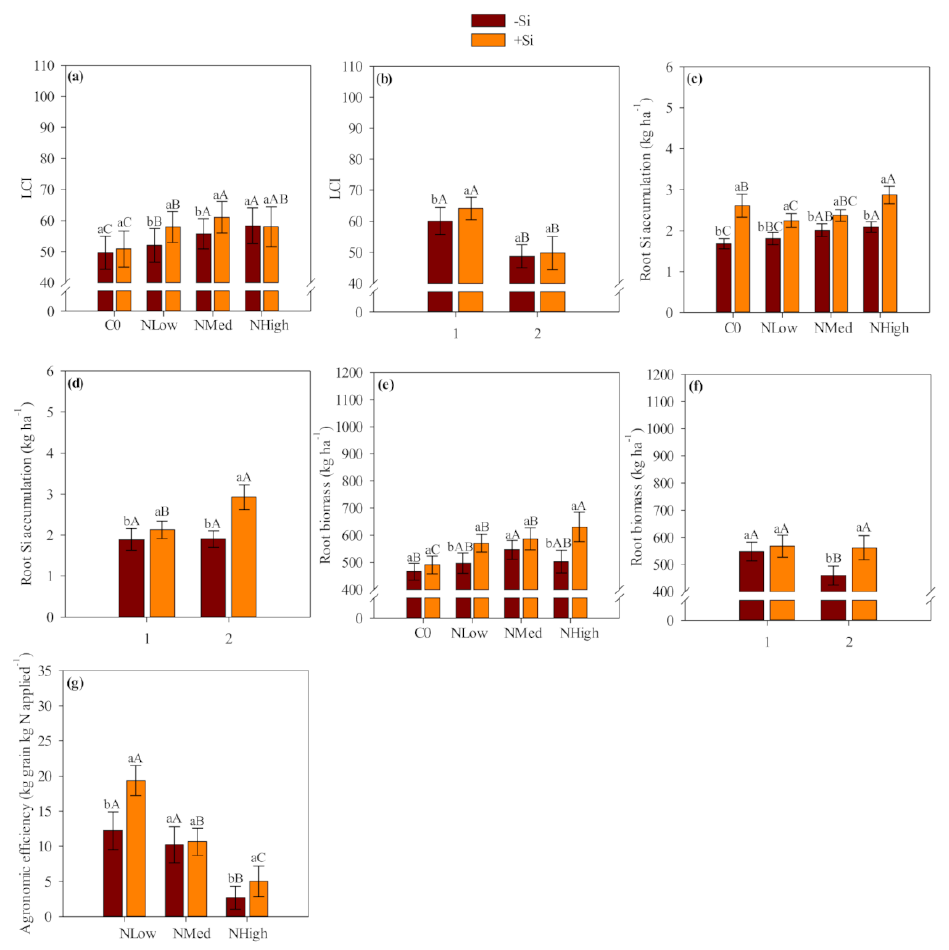
Figure 3. Wheat leaf chlorophyll index (LCI) ( a , b ), root Si accumulation ( c , d ), root biomass ( e , f ) and agronomic efficiency ( g ) affected by the interaction between Si amendment application and N levels or by the interaction between Si amendment application and years of